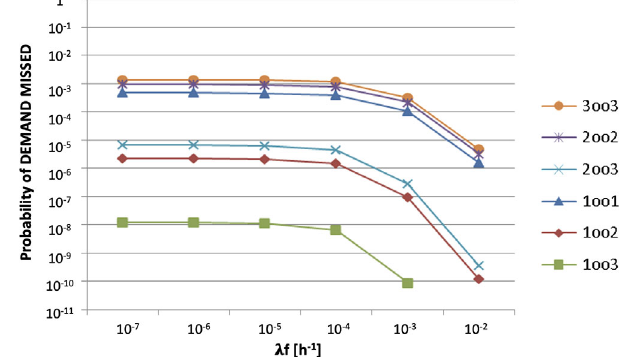
FIG. 11. Case I: Probability of false trigger against λ f between 1 × 10 − 7 h − 1 and 1 × 10 − 2 h − 1 .